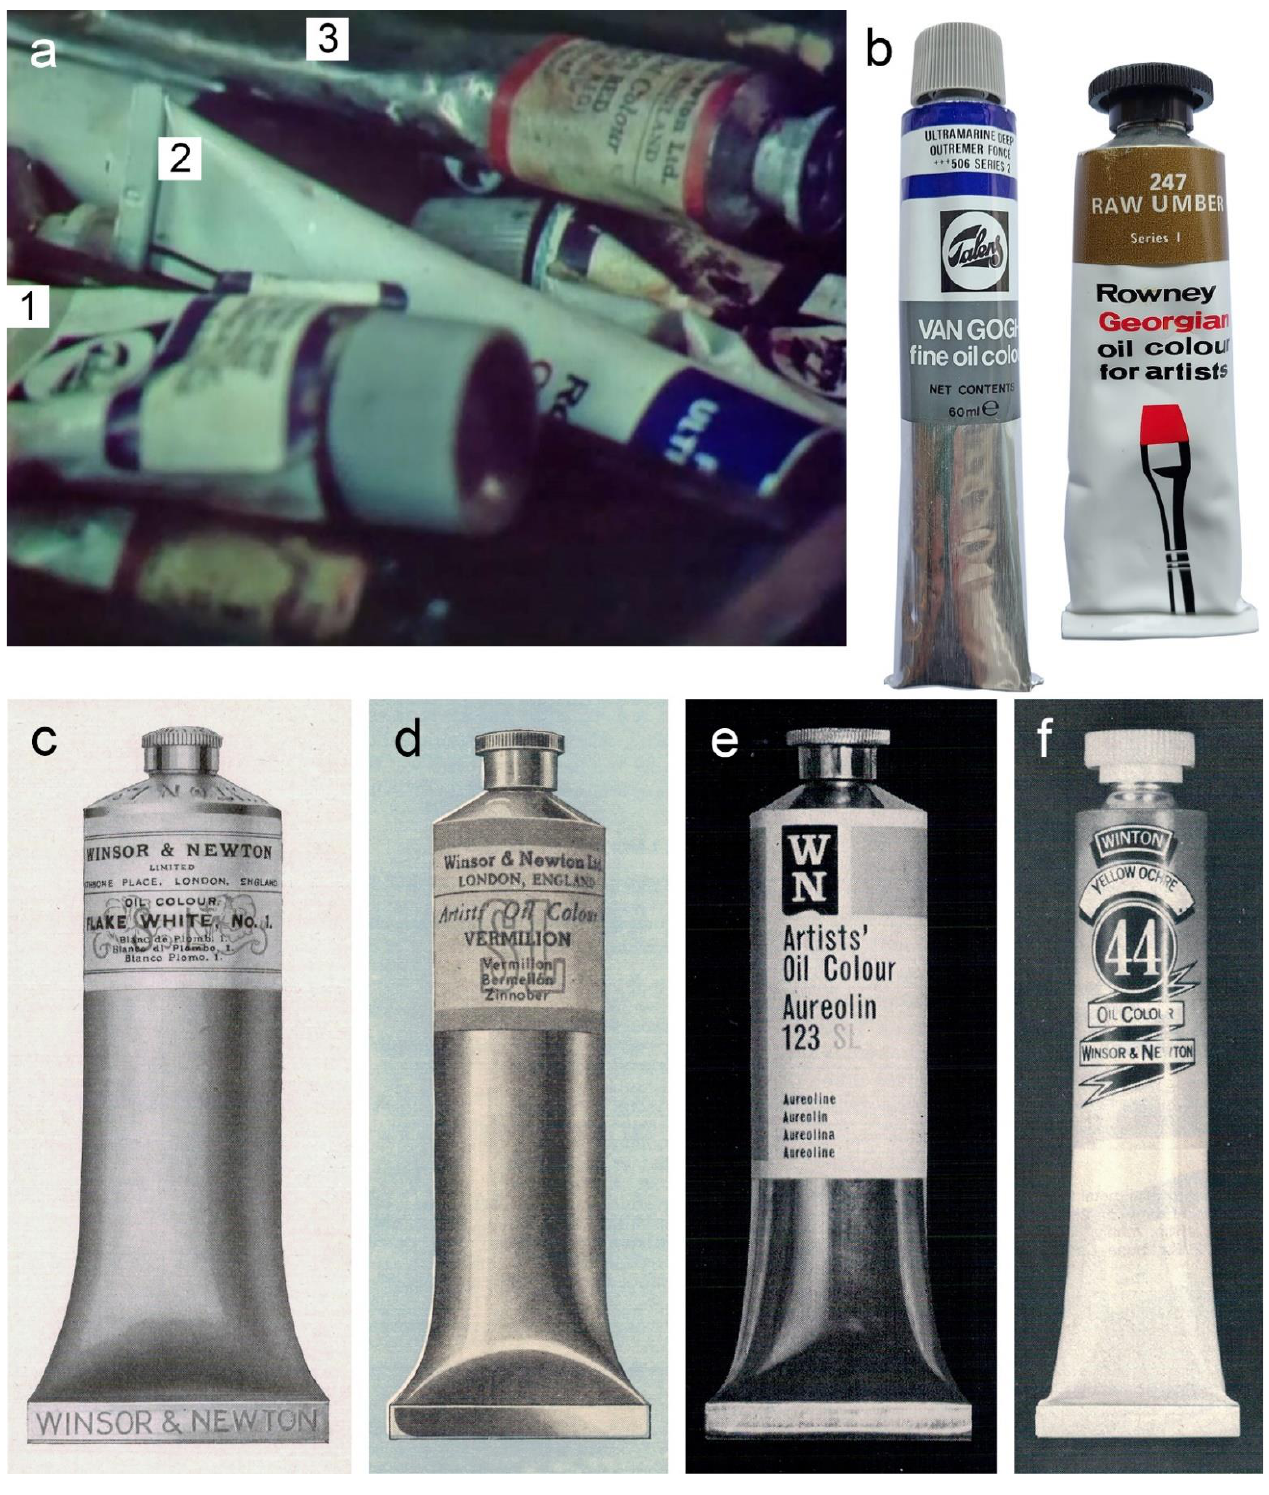
Figure 9. ( a ) Still image from the 1982 TV documentary showing the artist’s paint tubes from Royal Talens (1), Rowney (2) and W&N (3). Copyrights of Mediacorp TV Singapore Pte Ltd. ( b ) Authors reference Royal Talens (Van Gogh series) and Rowney (Georgian series) oil paint tubes from the 1980s. W&N oil paint tubes advertised in the company’s catalogue from: ( c ) 1934, ( d ) 1957, ( e ) 1963 and ( f ) 1979.